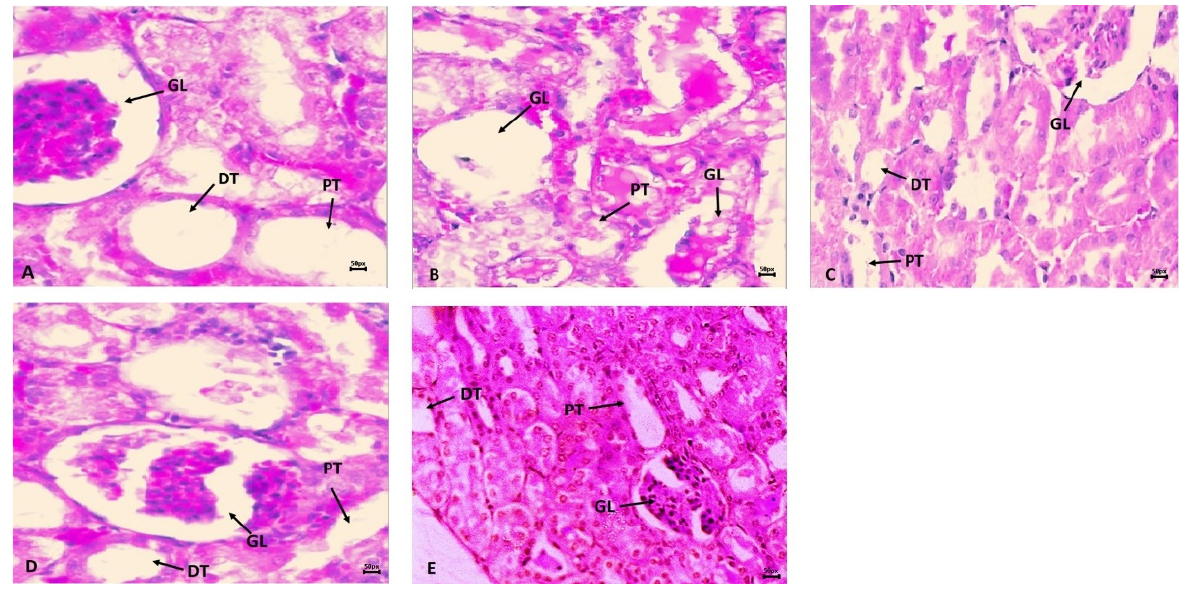
Figure 4. Protective effects of sesamin against cyclophosphamide induced renal toxicity. Hematoxylin and eosin (H and E) staining indicates ( A ) normal control (CNT) without any abnormality; ( B ) CP intoxication with clear abnormality such as necrosis in GL, PT, and DT. ( C ) SM10 + CP and ( D ) SM20 + CP is sesamin treatment with improvement in renal architect. ( E ) SM20 no significant changes in renal architect. Scale bar is 50px.